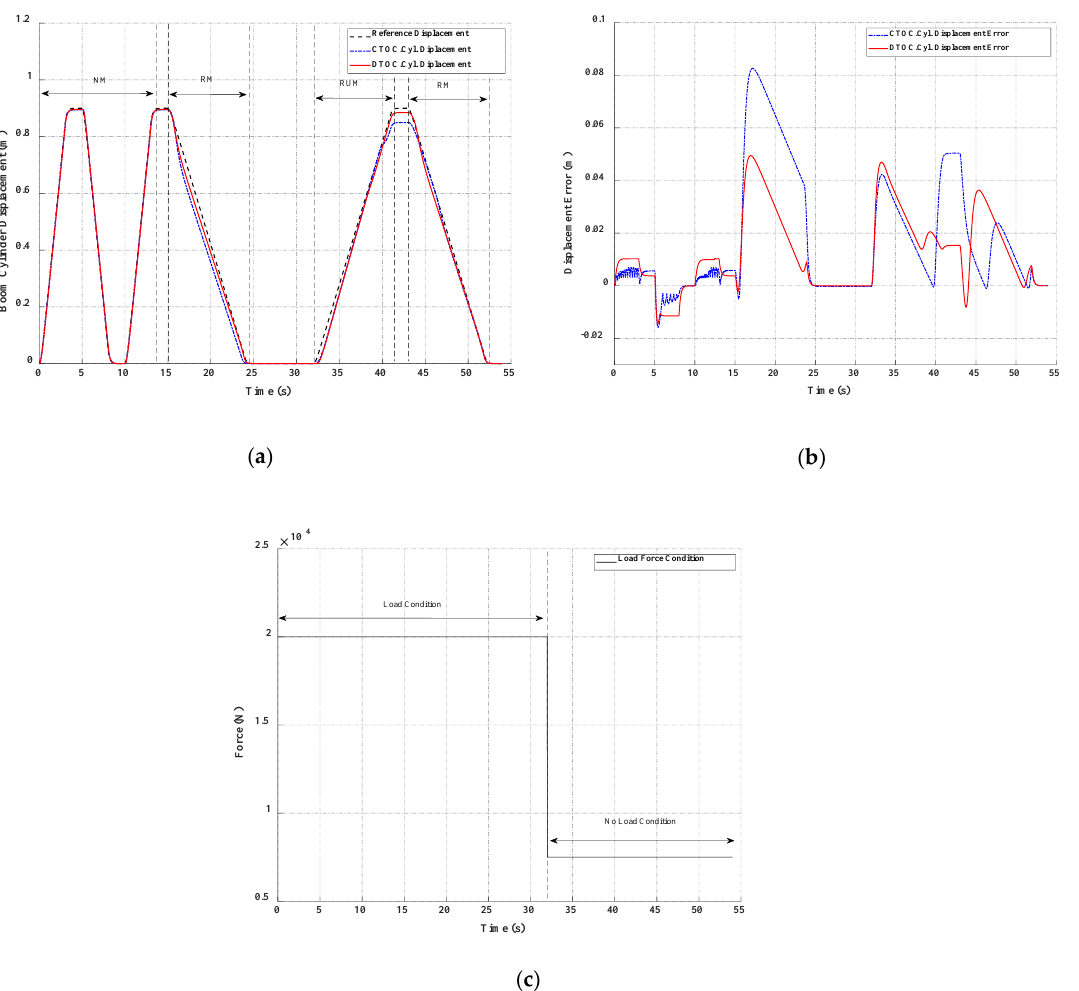
Figure 10. Displacement ( a ), error of the boom cylinder ( b ) and load force condition ( c ) (NM: normal mode, RM: regeneration mode, RUM: Reuse mode).